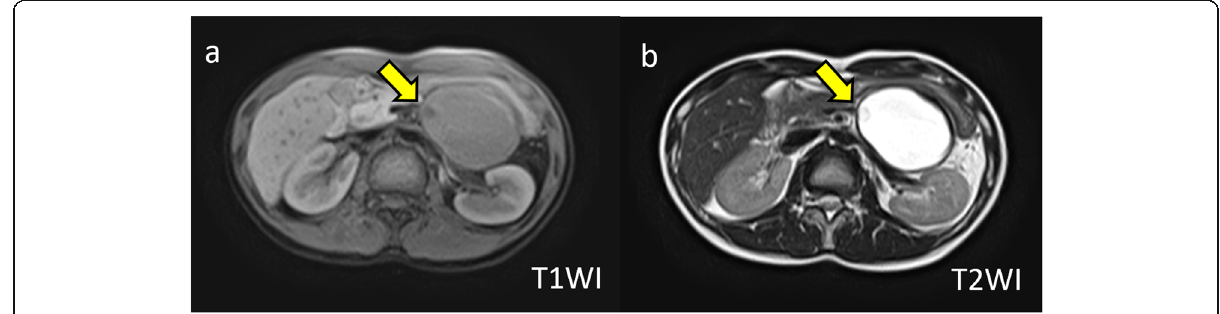
Fig. 2 a T1-weighted image. A cystic tumor with an internal septal formation was present in the pancreatic tail. The cystic lesion showed a hypo- intense signal with nodular lesion (arrow). b T2-weighted image. The cystic lesion showed a hyperintense signal with nodular lesion